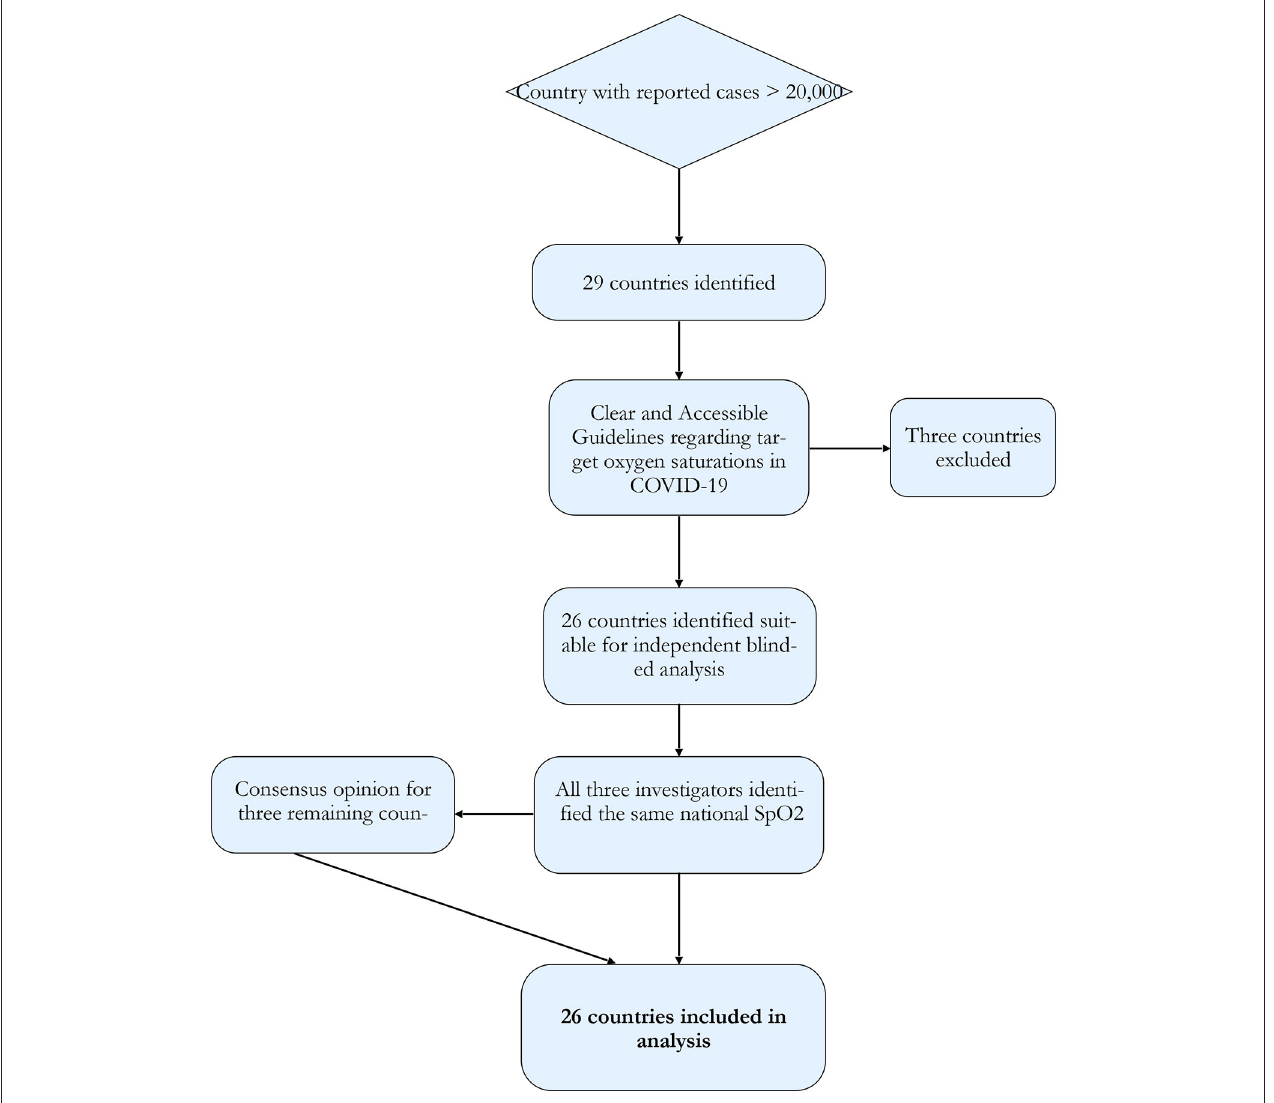
FIGURE 1 | Study protocol flowchart. Using the WHO situation report countries with case numbers over 20,000 were selected. These countries were subjected to analysis via three different, independent investigators for the ascertainment of nationally recommended target oxygen saturations.